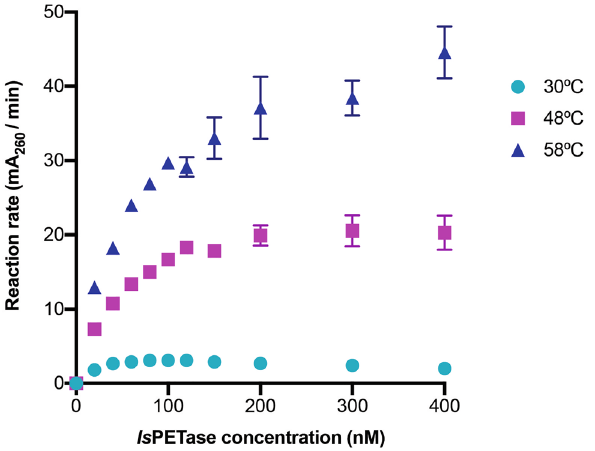
Figure 4. Kinetic profiles of TS-PETase. Initial rates of reaction in terms of mA 260 per minute at various enzyme concentrations of TS-PETase were determined at 30 °C, 48 °C, and 58 °C ( n ≥ 4 per time point and concentration). All measurements were performed on a NanoDrop 1000 and values reported with a path length of 1 cm. Error bars represent